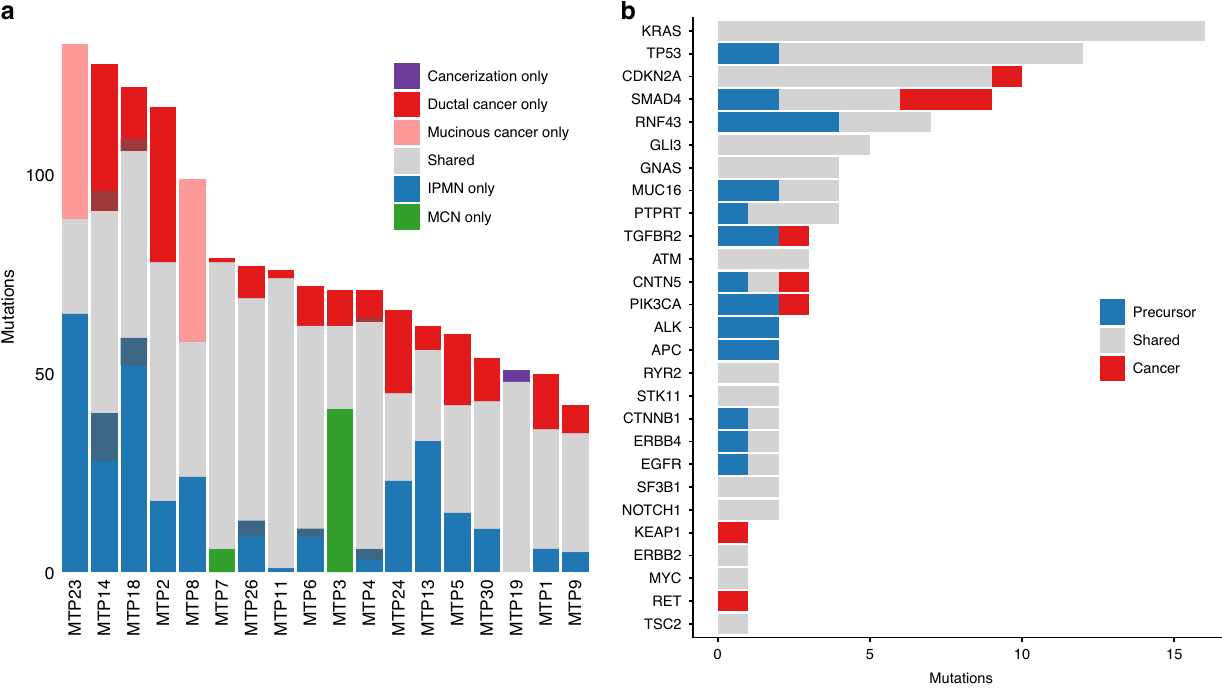
Fig. 1 Somatic mutations identi fi ed in matched noninvasive and invasive cancer samples. a In each patient sample, multiple mutations were shared between the noninvasive and invasive cancer samples (gray). In addition, some mutations were limited to the noninvasive (blue/green), while others were limited to the cancer (red/pink). Darker colors indicate alterations that were likely restricted to one component but where sequencing coverage in the second component was limited. The proportions of shared and distinct mutations varied between different lesions. b Somatic mutations in the most frequently mutated genes are categorized as shared between noninvasive and cancer (gray), limited to noninvasive (blue), or limited to cancer (red). Mutations in some genes (such as KRAS) were always shared, while others were enriched in samples from noninvasive ( RNF43 ) or cancer ( SMAD4 ).